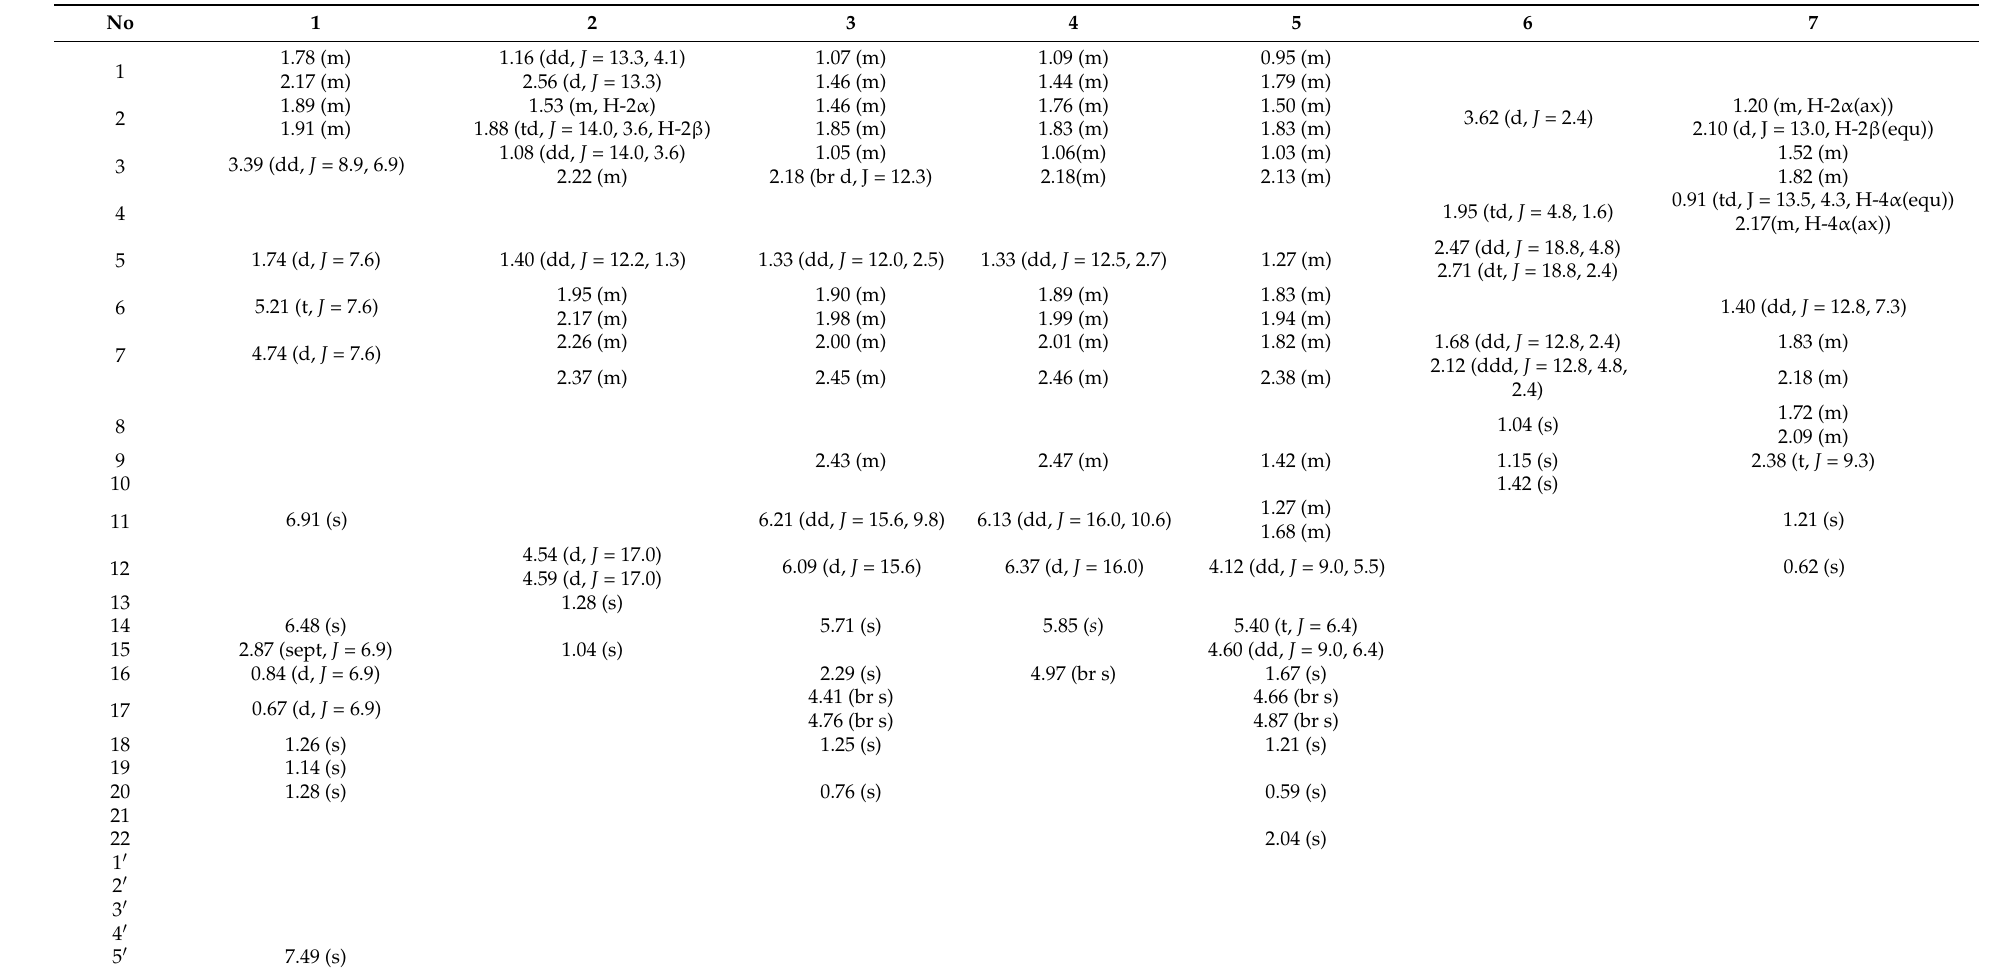
Table 2. 1 H-NMR Data for Compounds 1 – 7 in CDCl 3 ( δ in ppm, J in Hz, 500 MHz in CDCl 3